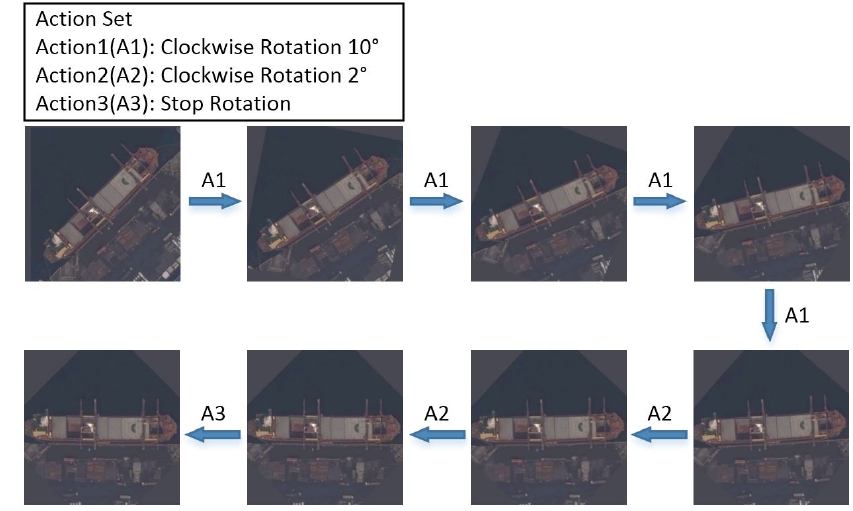
Figure 7. The action set and ship rotation